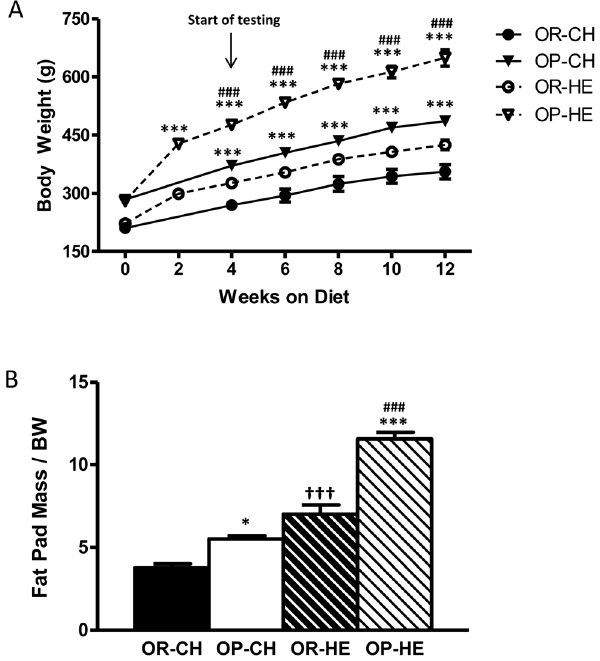
Figure 1. Body weights (A) and adiposity index (B) in chow- and HE-fed OP and OR rats. (A) OP rats weighed more than OR after 2-wks of HE-feeding and more than chow-fed OP animals after 4-wks. (B) Chow- and HE-fed OP rats had significantly heavier relative fat pad mass than OR counterparts, and HE-feeding resulted in increased adiposity of both OP and OR rats. Data are expressed as means 6 SEM, *P , 0.05, ***P , 0.0001 OP relative to OR within diet condition; {{{ P , 0.0001 HE-OR relative to chow-OR; ### P , 0.0001 HE-OP relative to chow-OP.